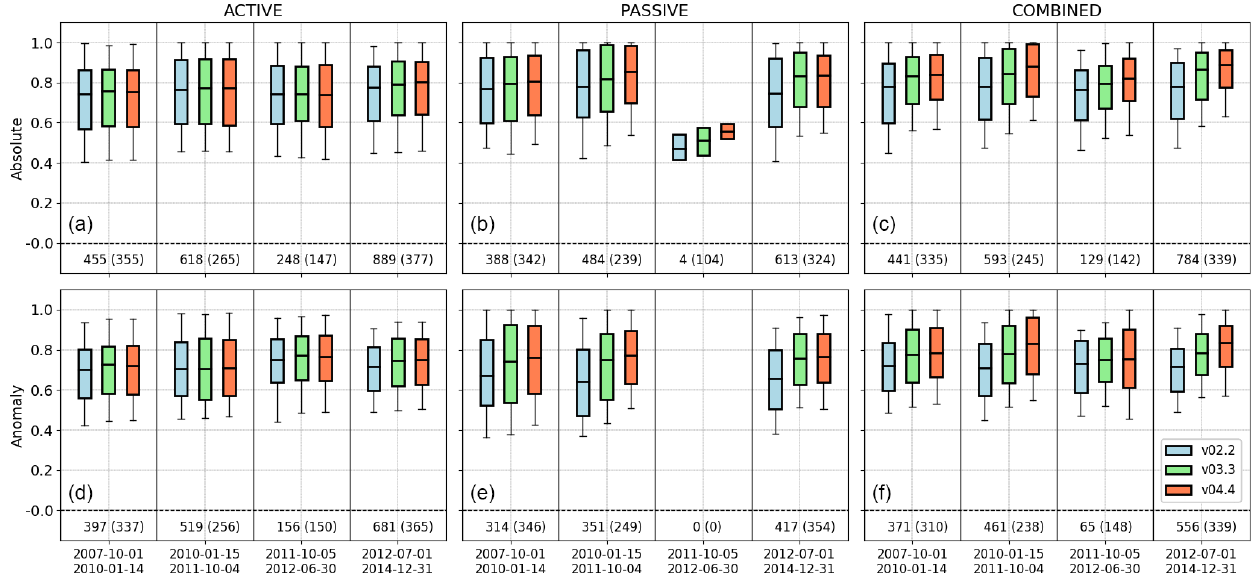
Figure 9. Box plots of correlations against the unknown truth of measurements from the ACTIVE (a, d) , PASSIVE (b, e) and COM- BINED (c, f) products, both for absolute time series (a–c) and soil moisture anomalies (d–f) . Box colours refer to the ESA CCI SM product versions v02.2, v03.3 and v04.4. The x axes represent different merging periods (see Fig. 2). Boxes represent the median and IQR, and whiskers represent the 10th and 90th percentiles of significant correlations ( p < 0 . 05) over all stations where at least 100 collocated mea- surements are available. The number of stations available for calculating the correlation statistics for a particular product and time period is shown below the zero line. The number in brackets shows the average number of collocated measurements available at each station for calculating correlation